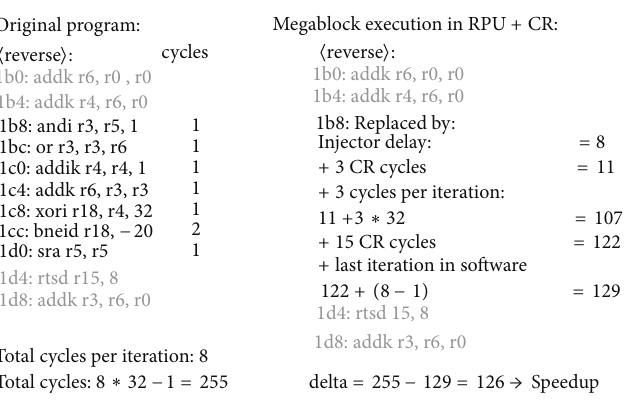
F 14: Cycle reduction for the reverse kernel, for a LMB-FSL